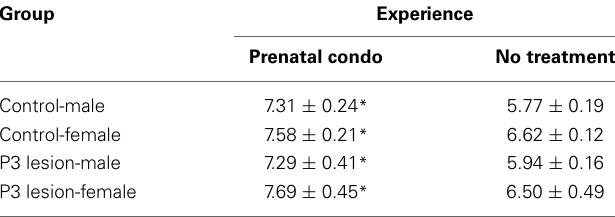
Table 7 | Summary of spine density on the basilar terminal.